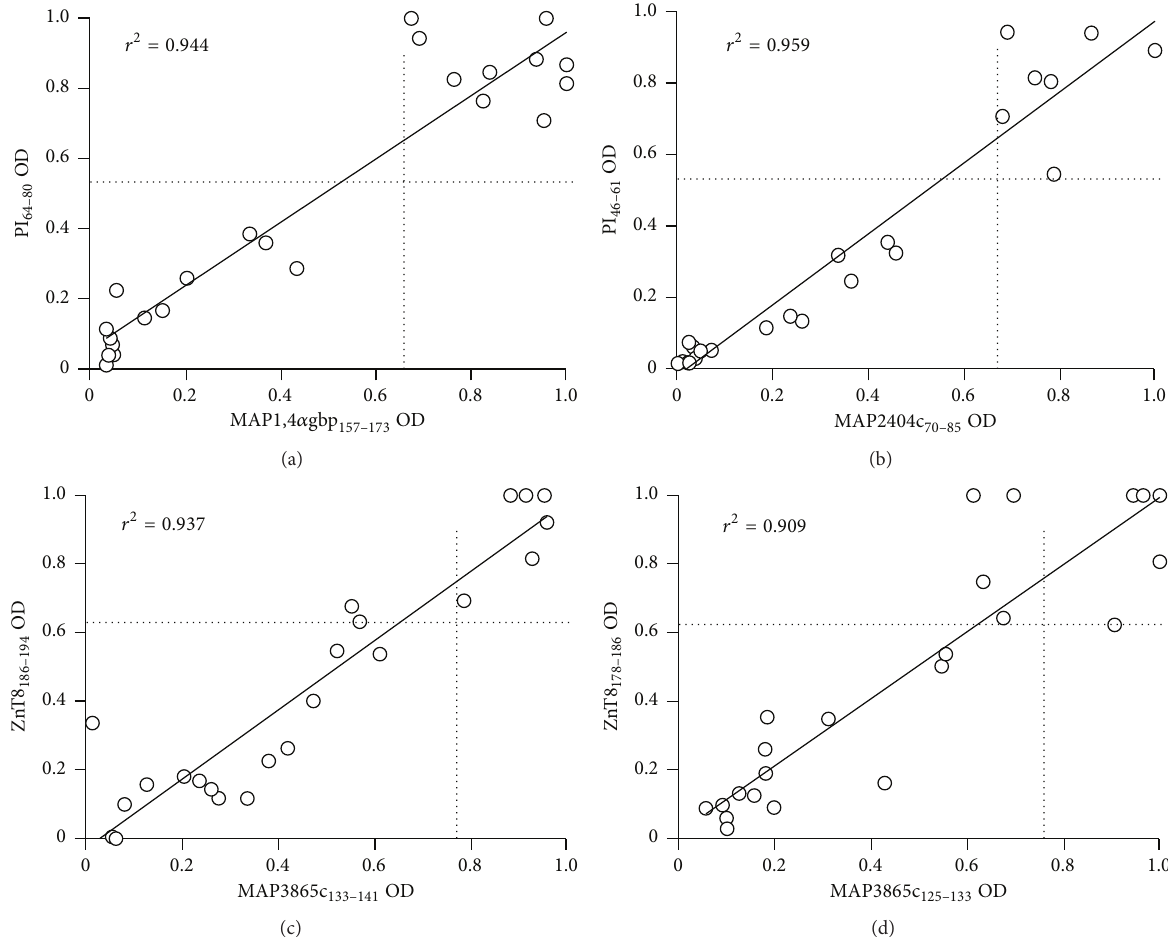
Figure 2: Correlation between Abs recognizing MAP and its homologous human epitopes in Sardinian children at risk for T1D. Correlations are shown between Abs against MAP1,4 𝛼 gbp 157 /ZnT 8 178 (d) in 23 at-risk children. Each circle represents Abs of one of ARS. The dotted lines indicate the cut-off for and MAP3865c 125 – 133 – 186 positivity used in each assay, as calculated by ROC